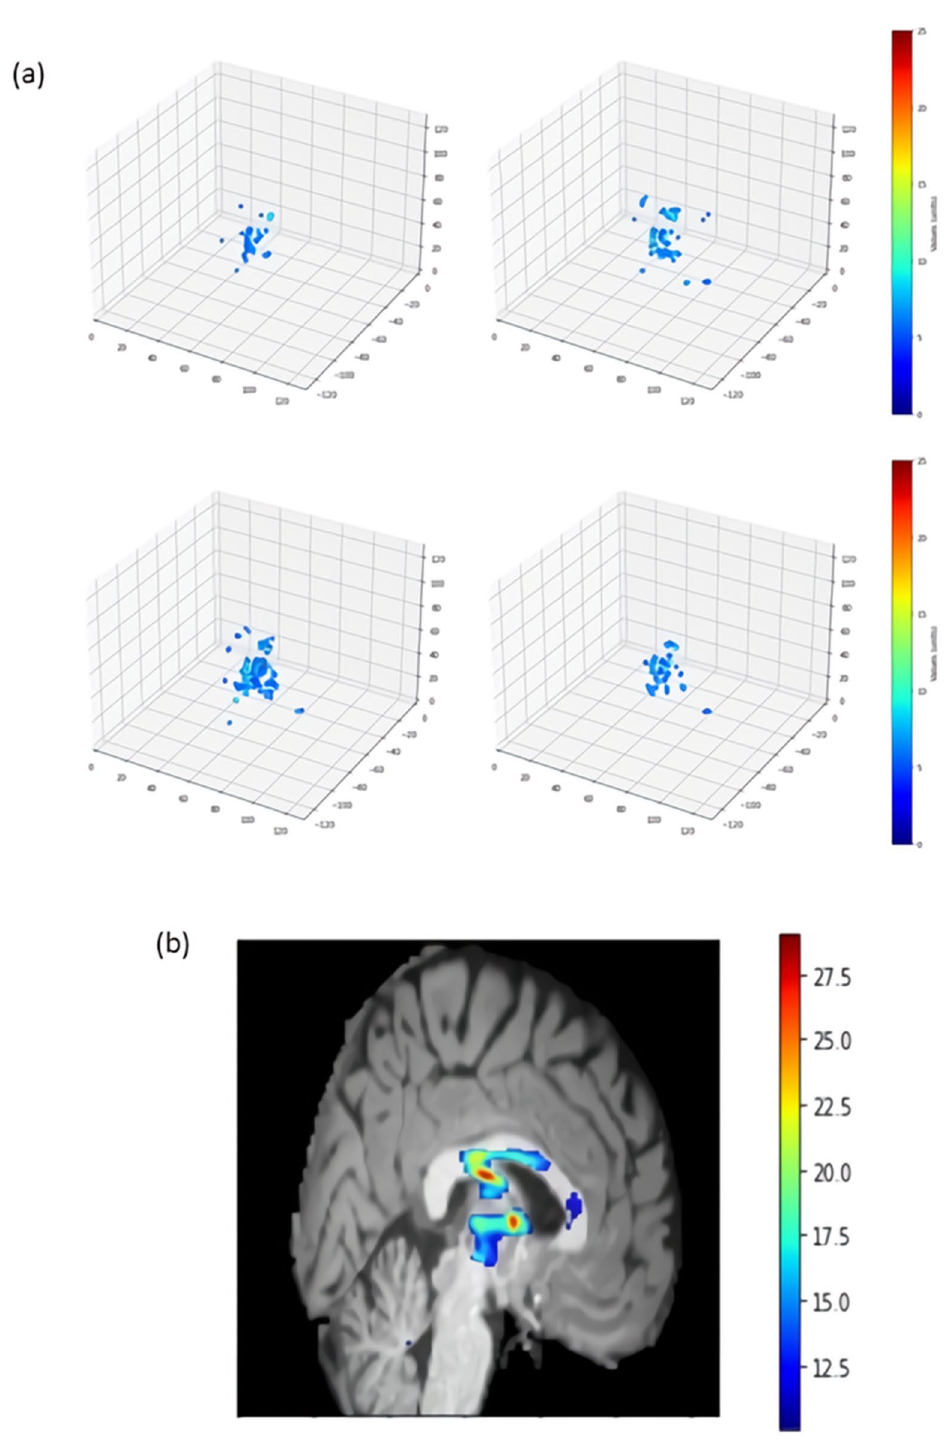
Figure 3. Integrated gradient (IG) analysis results. ( a ) Points with absolute IG > 5 in the four CV model sets from 100 individuals with the youngest predicted age. ( b ) A brain image at the x-coordinate of 62. Voxels with absolute IG > 10 are highlighted with